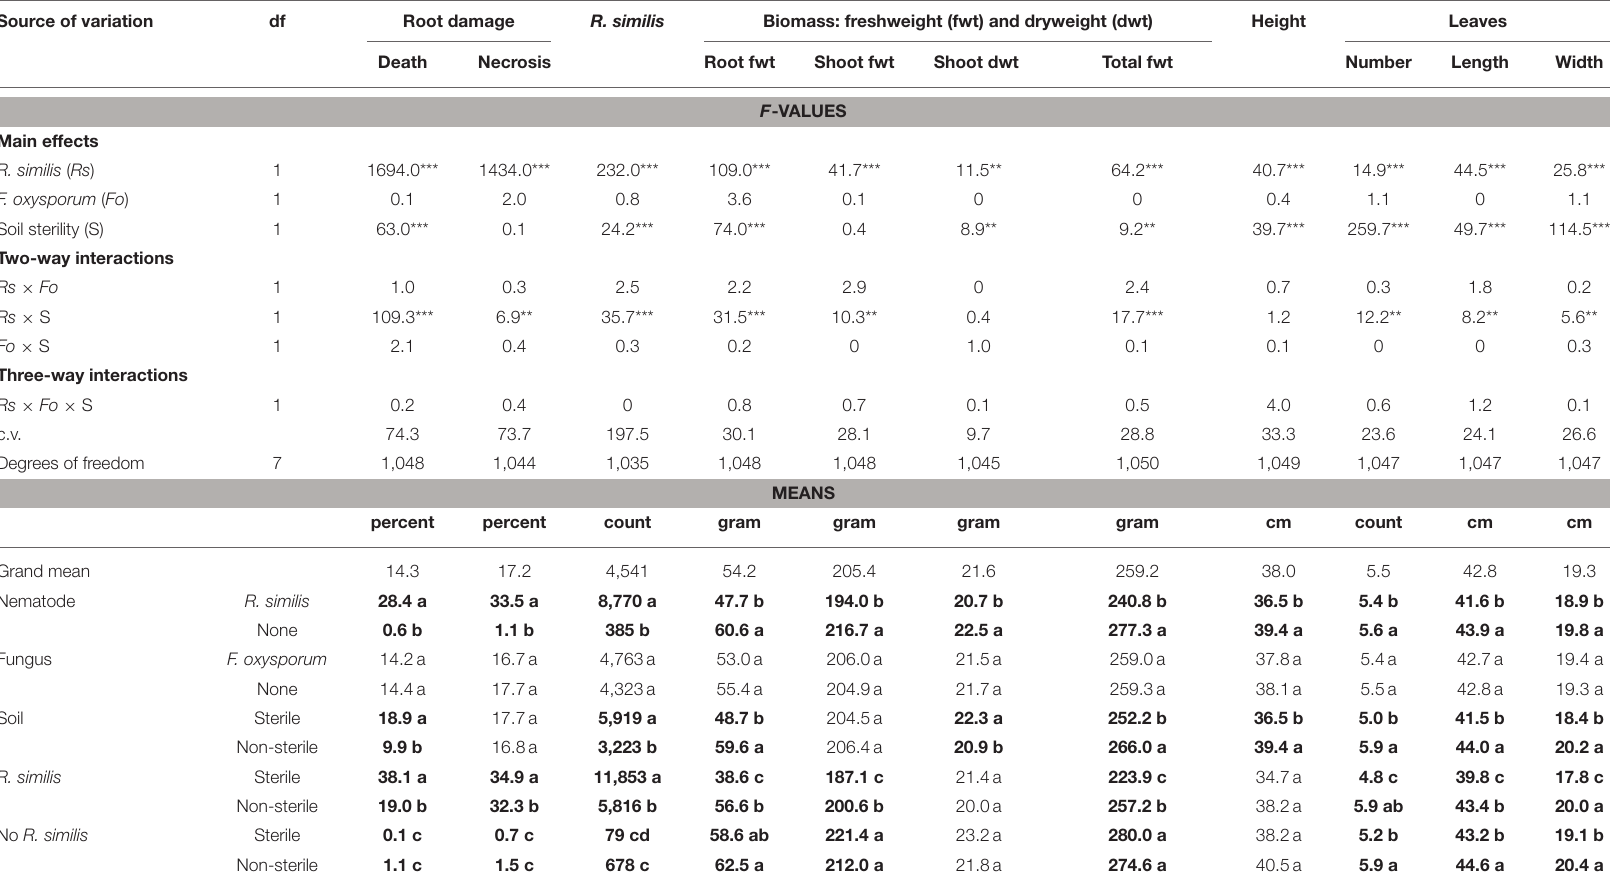
TABLE 1 | Effect of soil sterility on infection symptoms of Radopholus similis and Fusarium oxysporum in tissue culture banana plants grown under adequate nutrient supply. Source of